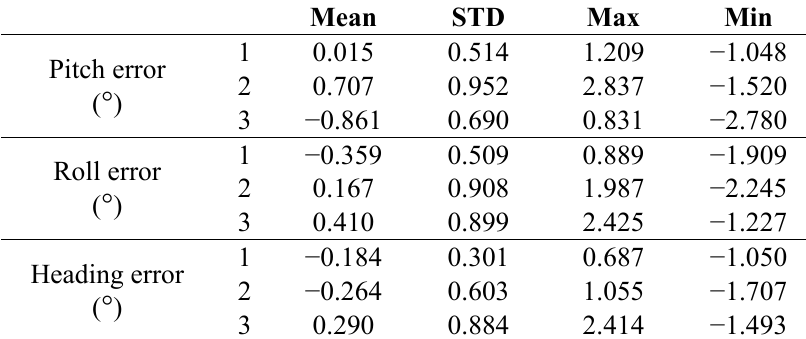
Table 3. Statistics of the first experiment.